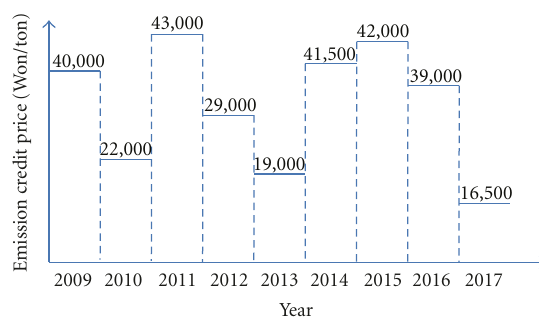
Figure 26: Variable emission credit prices.